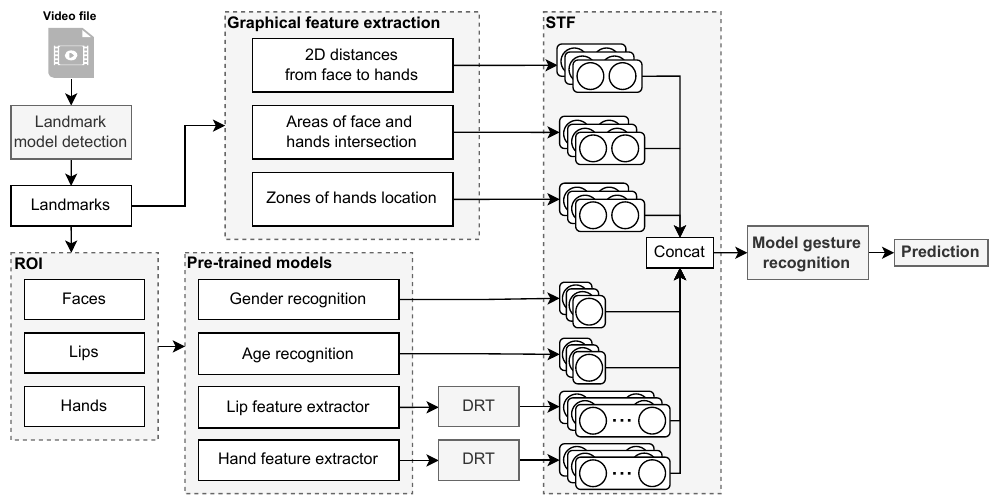
Figure 6. Proposed gesture recognition method. ROI—region-of-interest. DRT—dimensionality reduction technique. STF—spatio-temporal